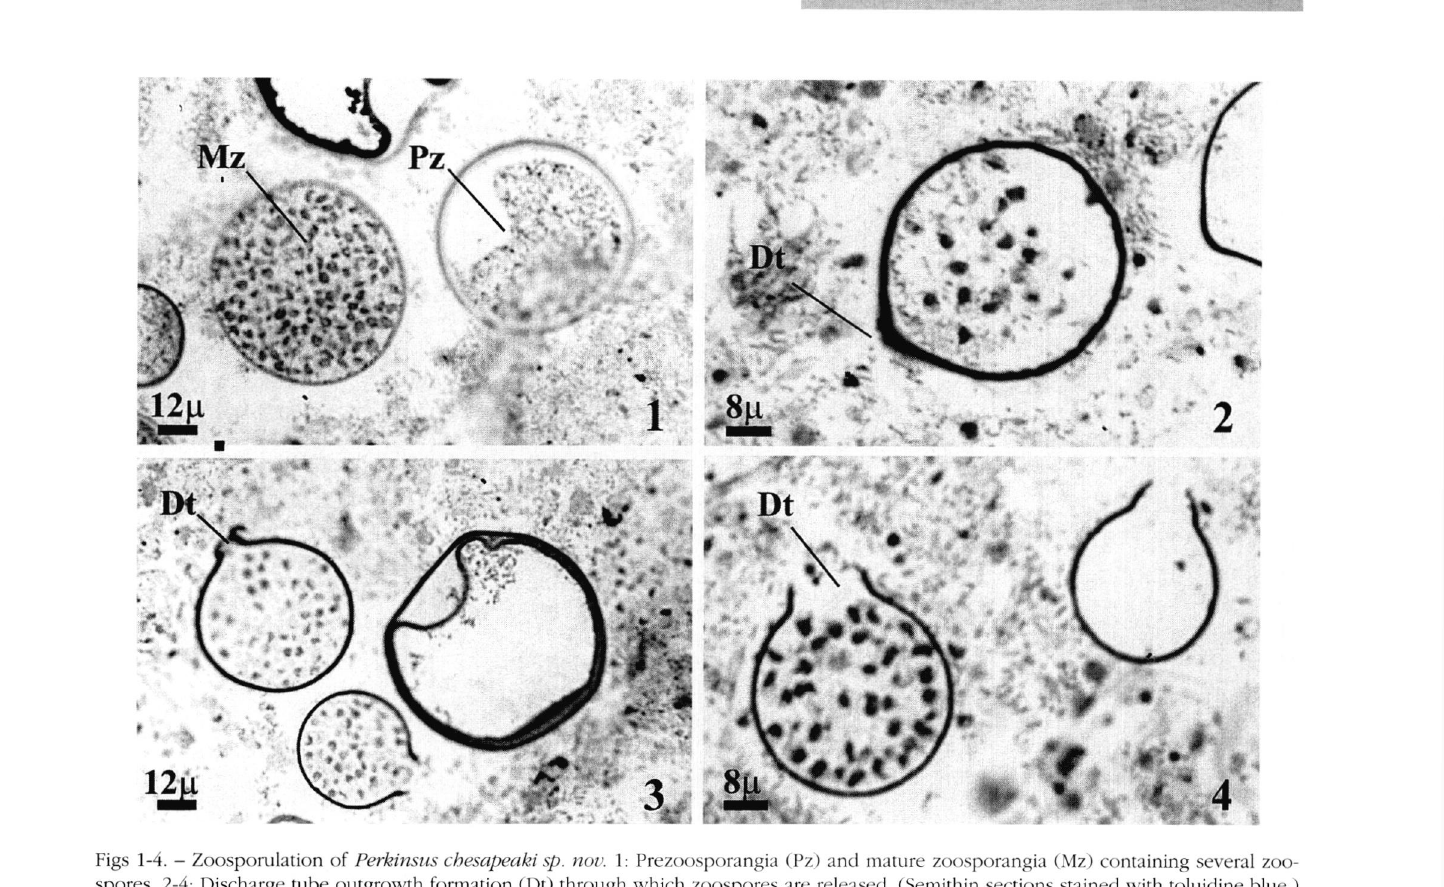
Figs 1-4. - Zoospoailation of Perkinsus chesapeaki sp. nov. 1: Prezoosporangia (Pz) and mature zoosporangia (Mz) containing several zoo­ spores. 2-4: Discharge tube outgrowth formation (Dt) through which zoospores are released. (Semithin sections stained with toluidine blue.)